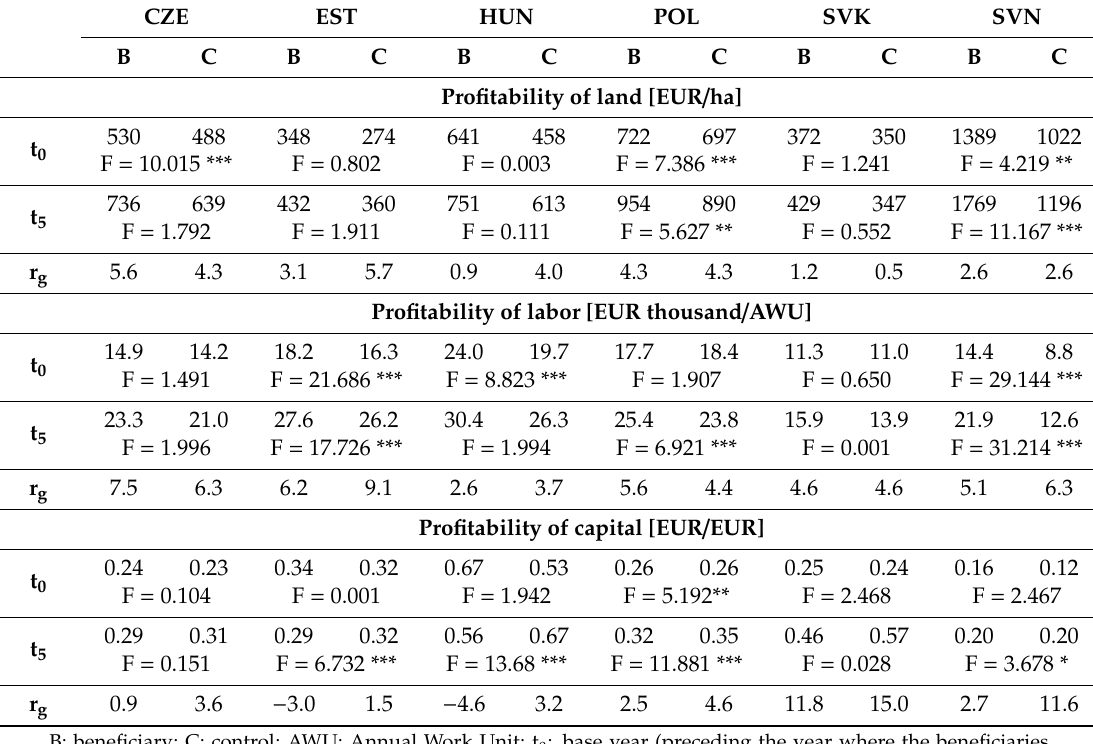
Table 7. Profitability of productive input (measured as Gross Farm Income) of beneficiary farms which accessed pro-investment funds under the second pillar of the CAP and of control farms in the base year (preceding the year where the beneficiaries accessed the pro-investment mechanisms under the second pillar of the CAP) and in the fifth year after they accessed the respective